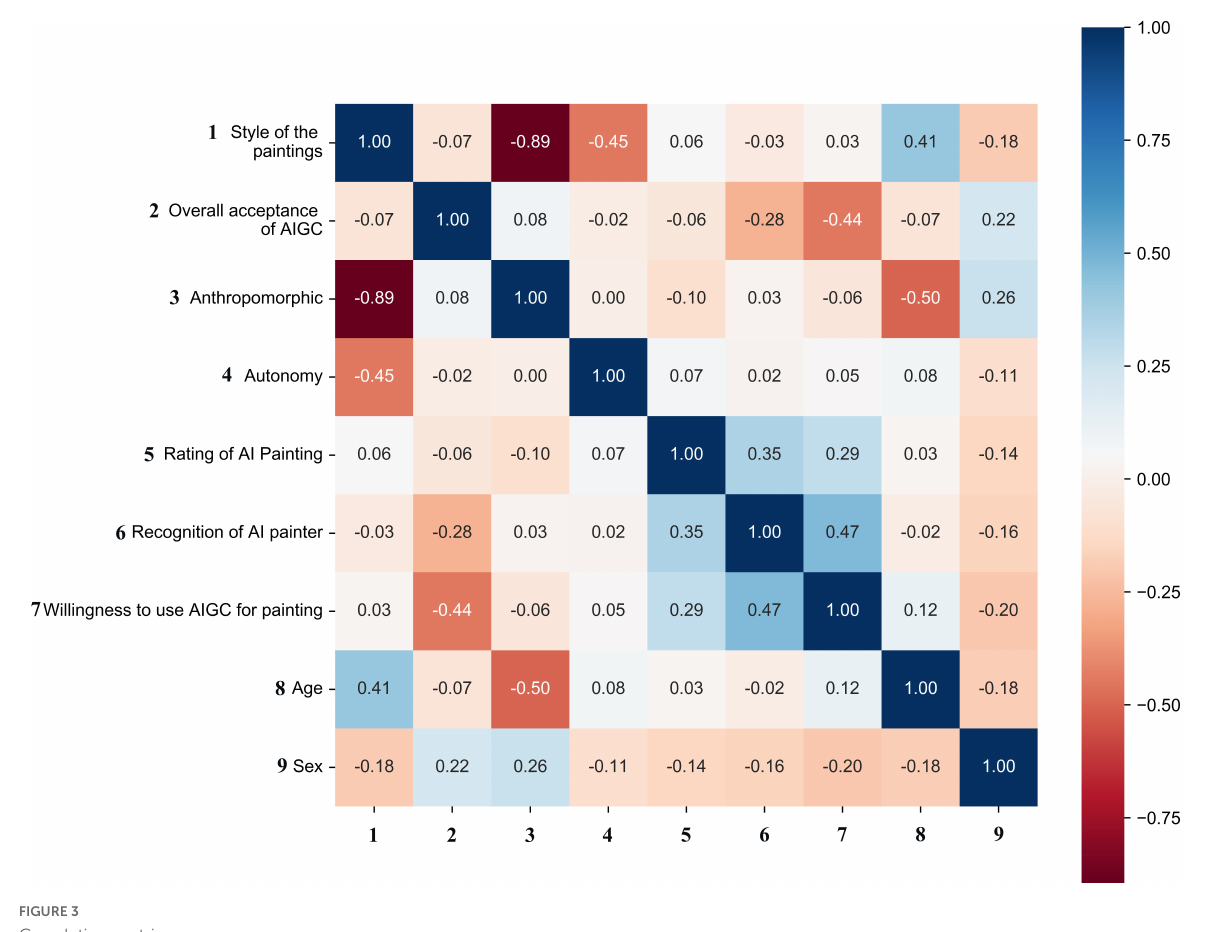
FIGURE3 Correlation